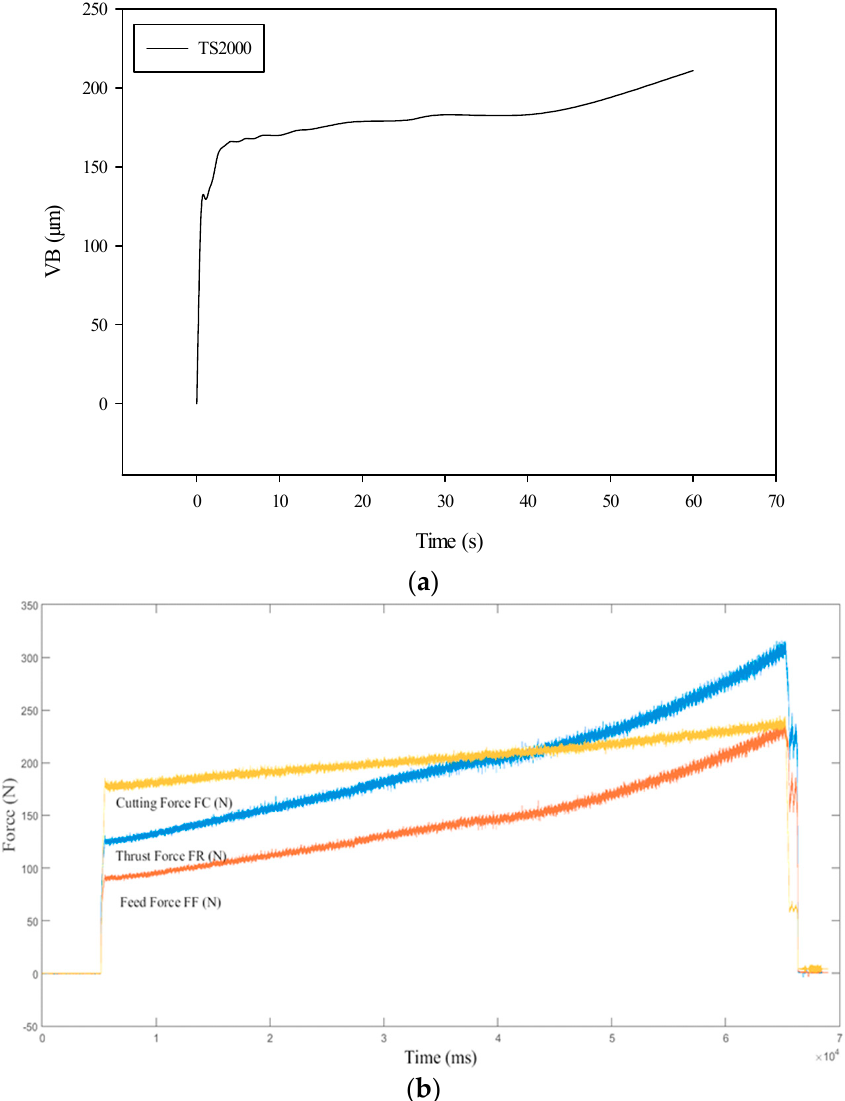
Figure 8. ( a ) Flank wear (VB); ( b ) cutting forces profile of insert TS2000 in 60 s of cutting.